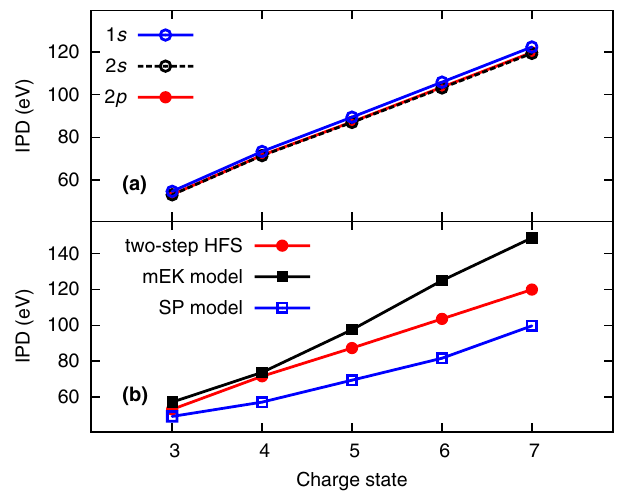
FIG. 7. Plots of the ionization potential depression. (a) Com- parison for all orbitals of Al calculated with the two-step HFS approach. (b) Comparison of various methods: two-step HFS model, modified EK model, and SP model. The predictions of the latter two are taken from Ref. [22].